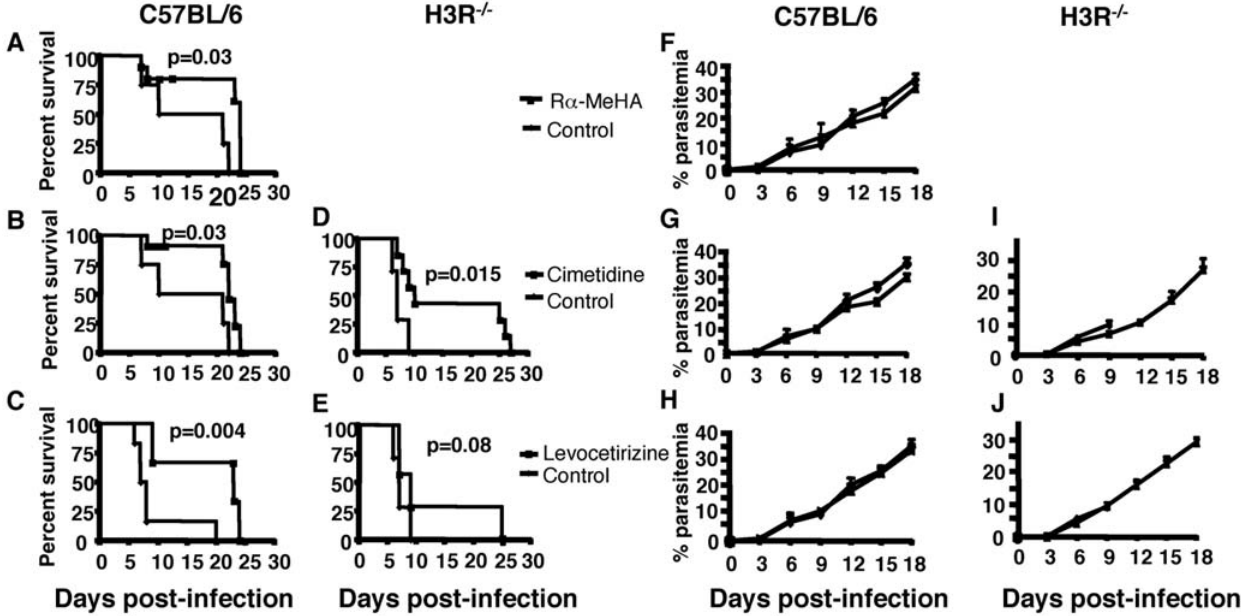
Figure 7. Effect of preventive treatment with histamine receptor agonists and antagonists on the occurrence of cerebral malaria. Wild-type C57BL/6 and H3R 2 / 2 mice were left untreated (diamonds) or treated (squares) with a H3R agonist R- a -MeHA or either the H1R or H2R inhibitors, respectively, Levocetirizine, and Cimetidine, before and during infection with 10 6 infected erythrocytes per mouse. These data are from two independent experiments. Significant differences in mortality/survival (A, B, C, D, E) were observed between drug-treated and untreated mice using the log-rank test. No significant differences in parasitemia between treated and untreated groups (F, G, H, I, J) were observed.